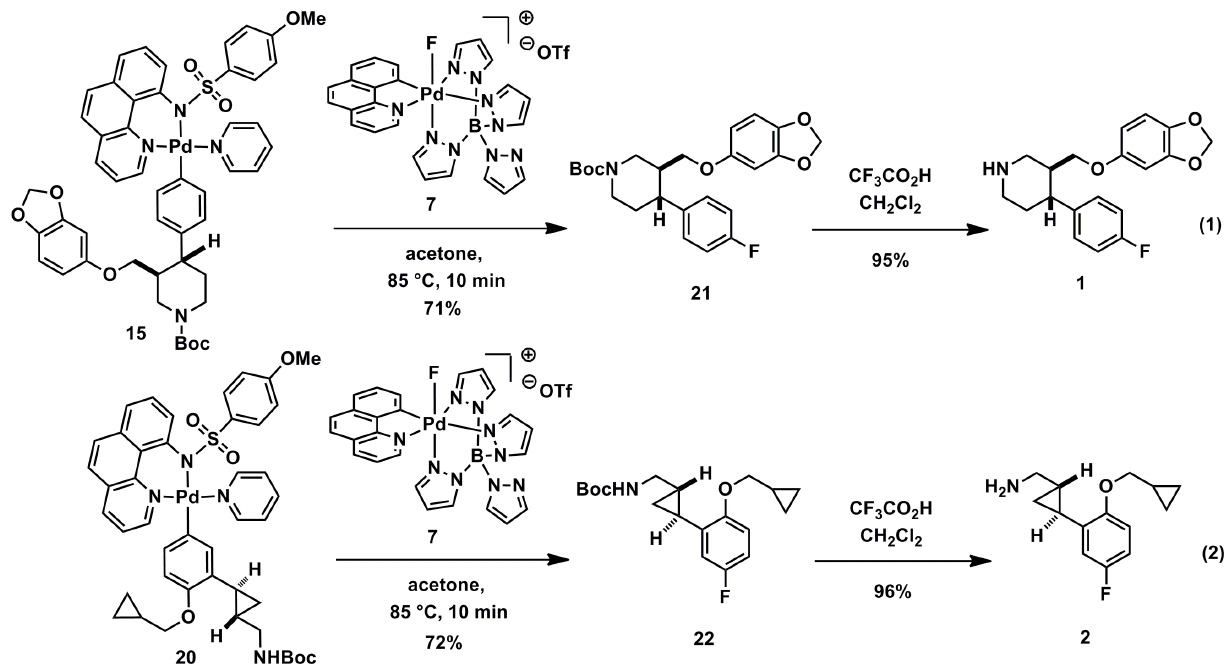
Figure 7. Synthesis of aryl fluorides 1 and 2 via late-stage fluorination with electrophilic reagent 7.